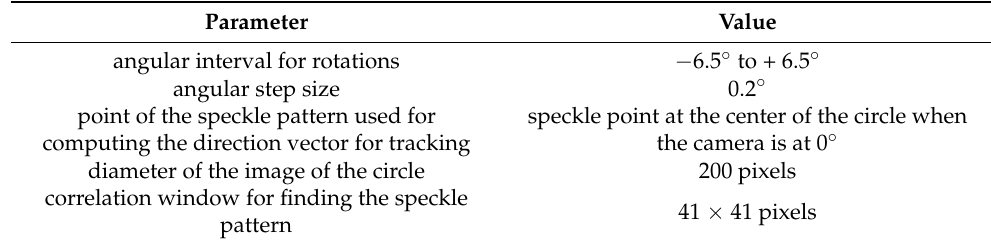
Table 6. Experimental conditions for Experiment